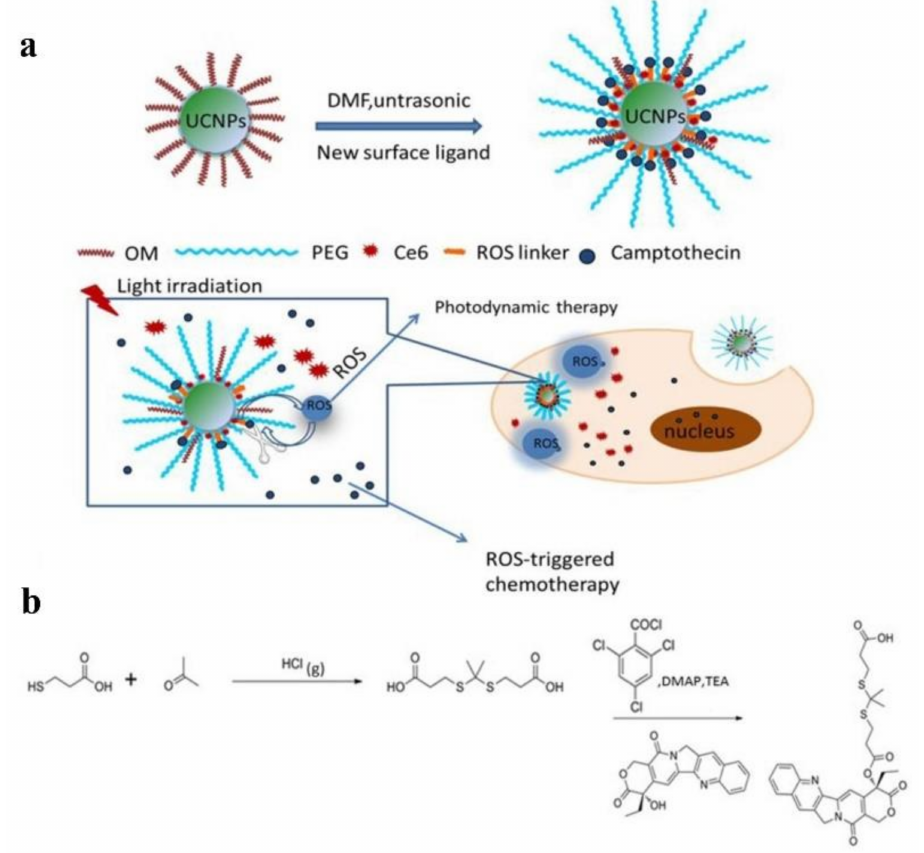
Figure 5. ( a ) Schematic illustration of the preparation of Ce6-CPT-UCNPs and concept of the light-regulated ROS-activated Ce6-CPT-UCNPs, OM: oleylamine; ( b ) Synthesis of ROS-responsive camptothecin, the product was abbreviated as TL-CPT; reproduced with the permission from [165], Copyright (2017) Ivyspring International